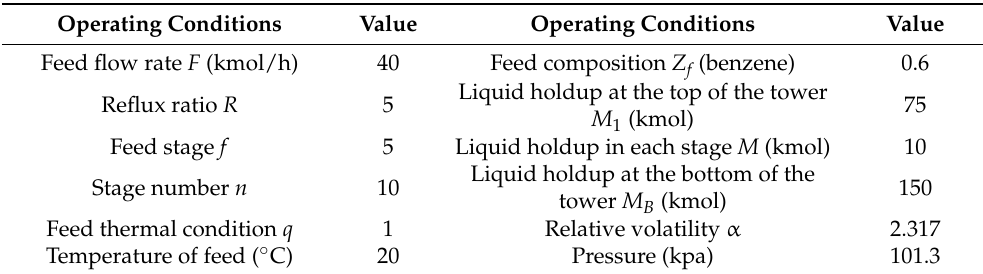
Table 2. Operating conditions of the distillation column in Case